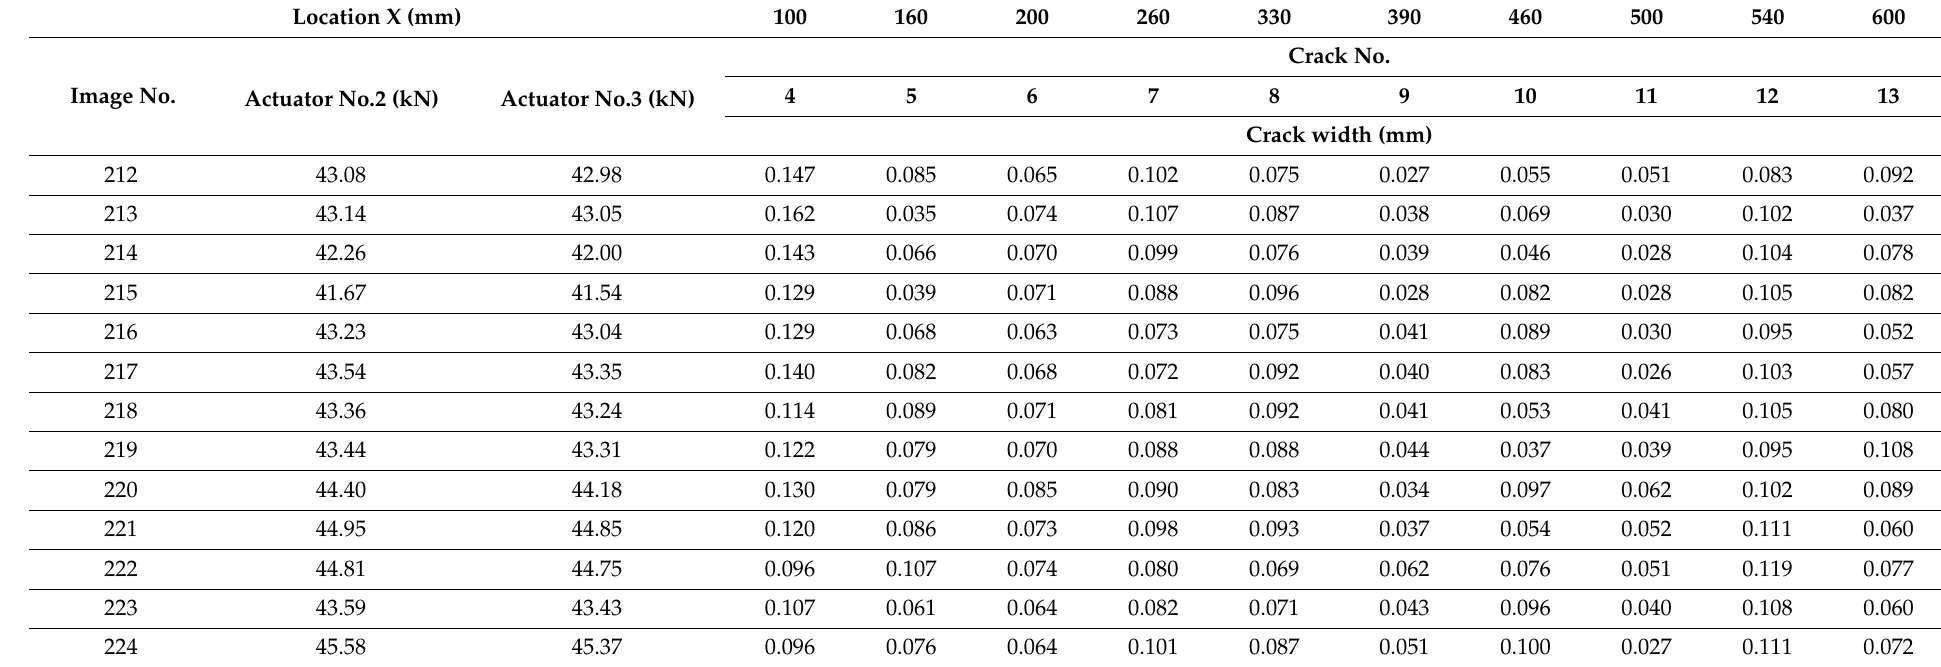
Table 7. Crack width results for beam A2M-2 (consecutive images).